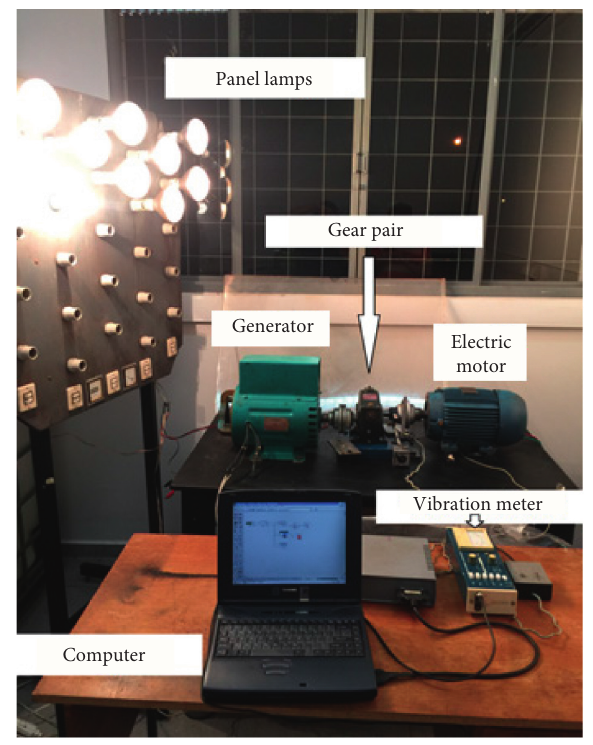
Figure 4: Workbench with its